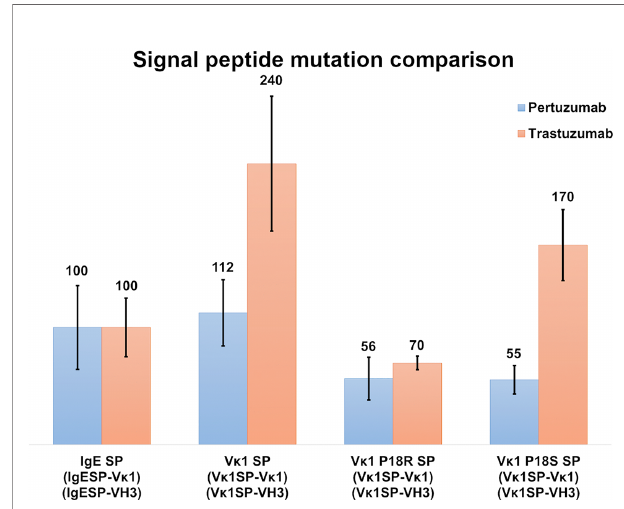
FIGURE 4 | Recombinant antibody production (%) with IgE, V k 1 and mutated V k 1 SPs, (V k 1 P18R and V k 1 P18S) against the wild-type V k 1|VH3 Pertuzumab (blue) and Trastuzumab (orange)